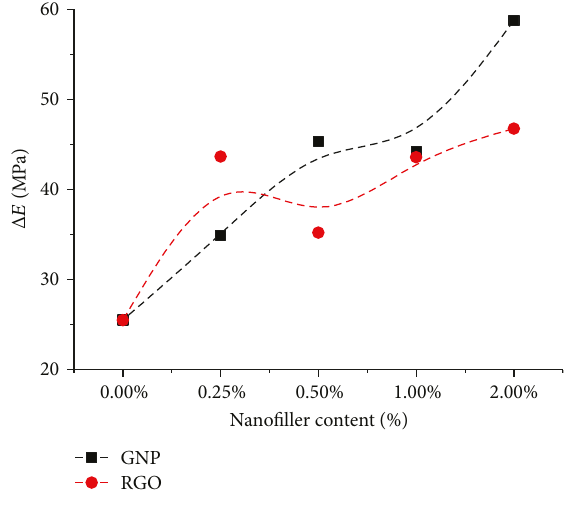
e ff ect improvement Δ E for PU40 nanocomposites.